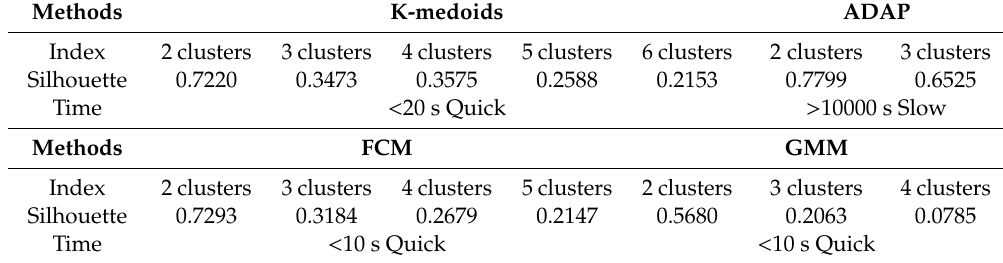
Table 4. Comparison of different clustering methods.